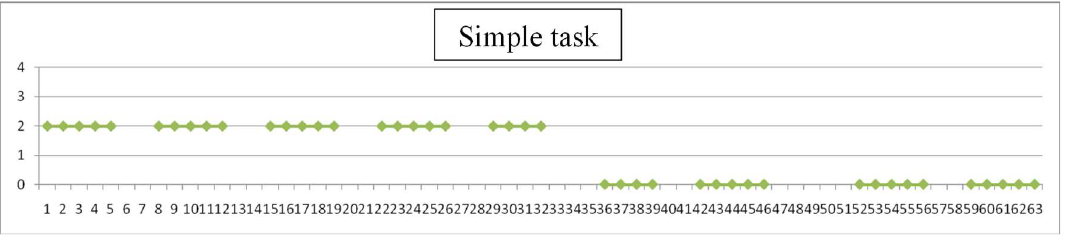
Figure 12. “ Simple task” reached a level of “no difficulty” at midpoint of training period.